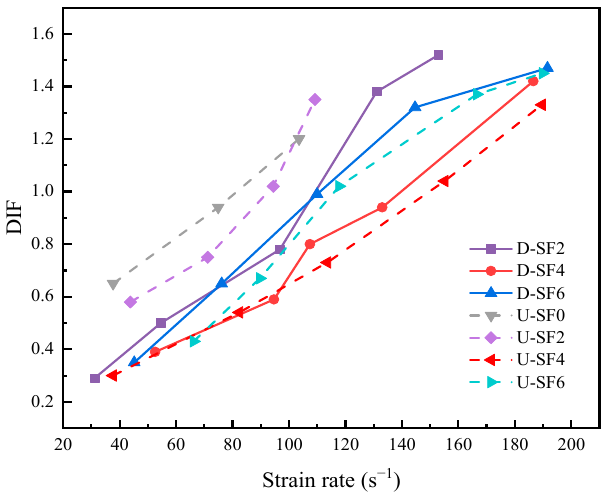
Figure 5. The effect of fiber content on strain rate.